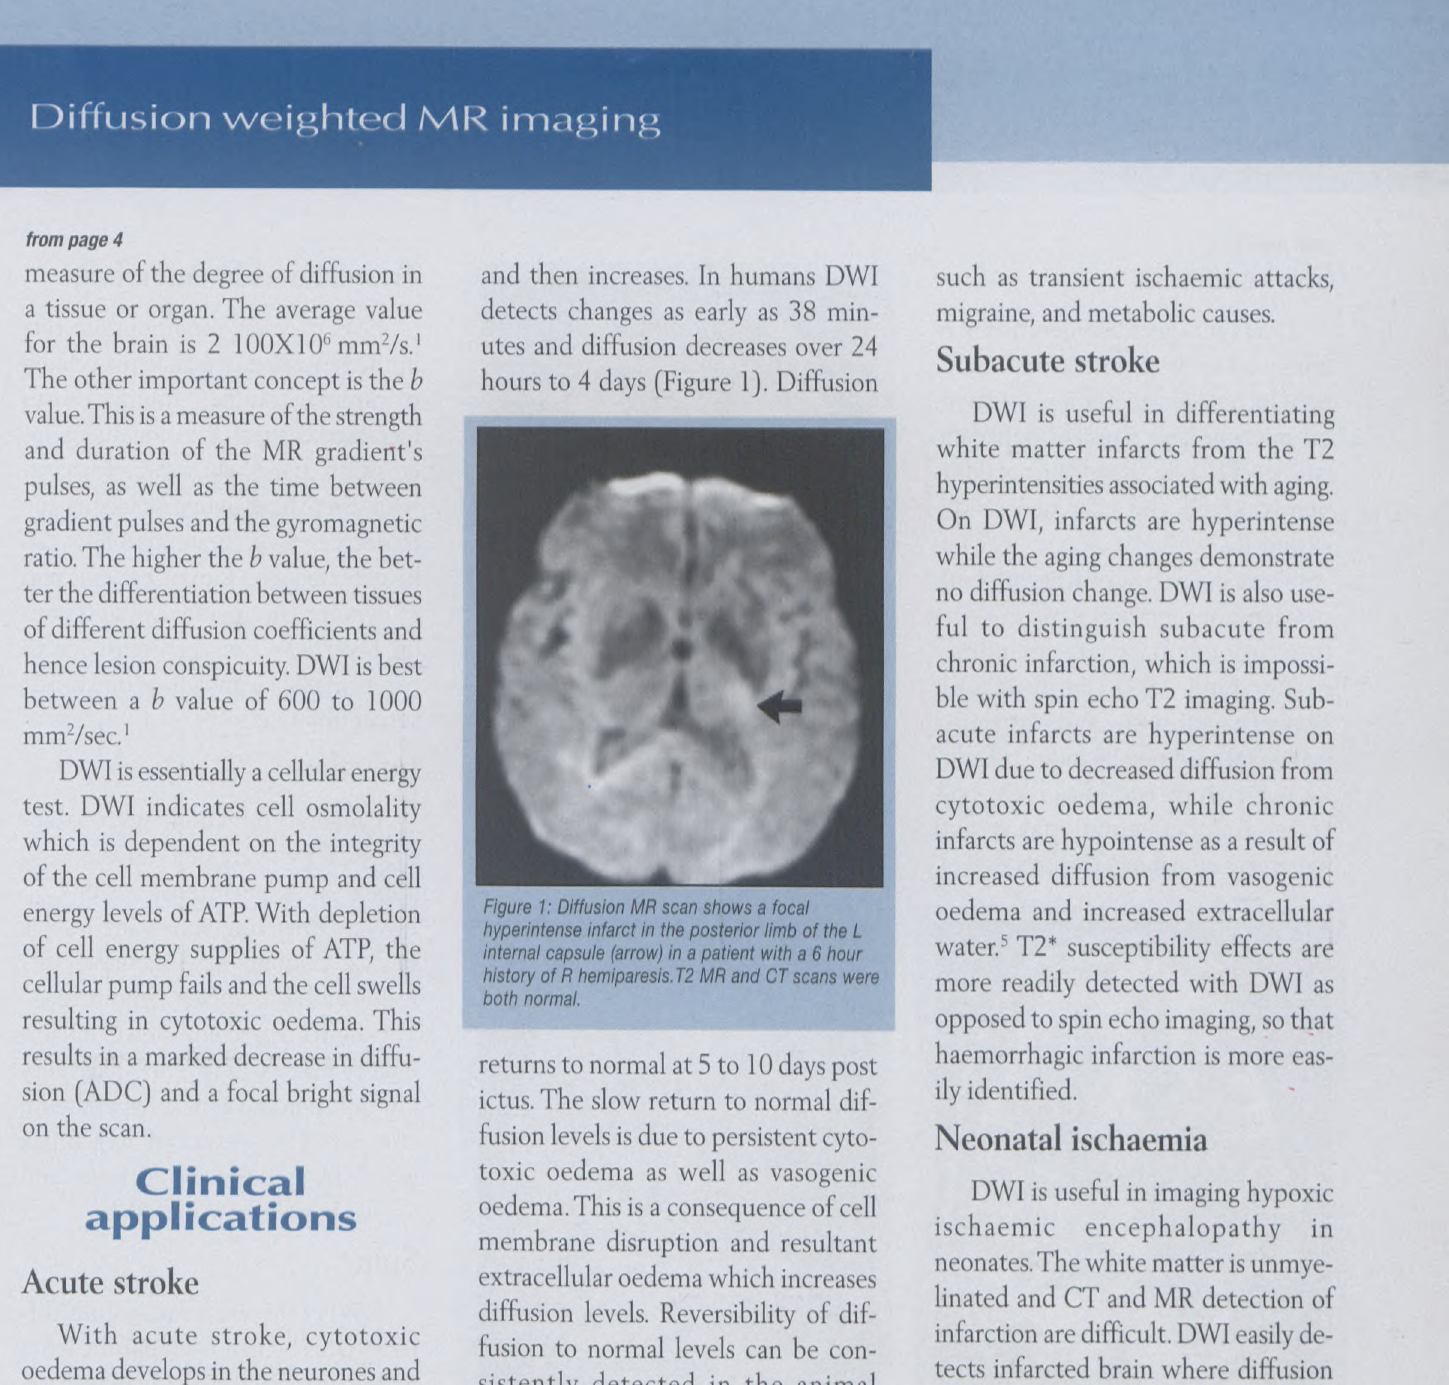
Figure 1: Diffusion MR scan shows a focal hyperintense infarct in the posterior limb of the L internal capsule (arrow) in a patient with a 6 hour history of R hemiparesis. T2 MR and CT scans were both